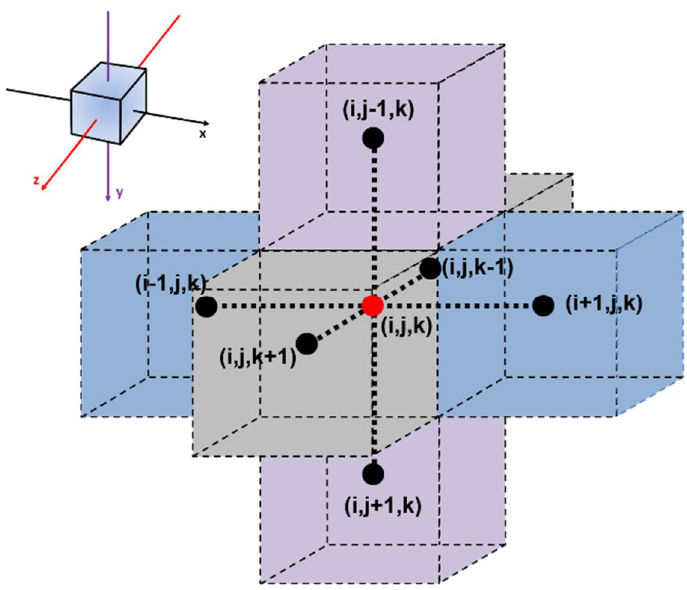
Figure 2. The central mesh element ( i , j , k ) surrounded by its six neighboring mesh elements as used in cubic lattice for the MC and the FD methods (Adapted from [18,19]).